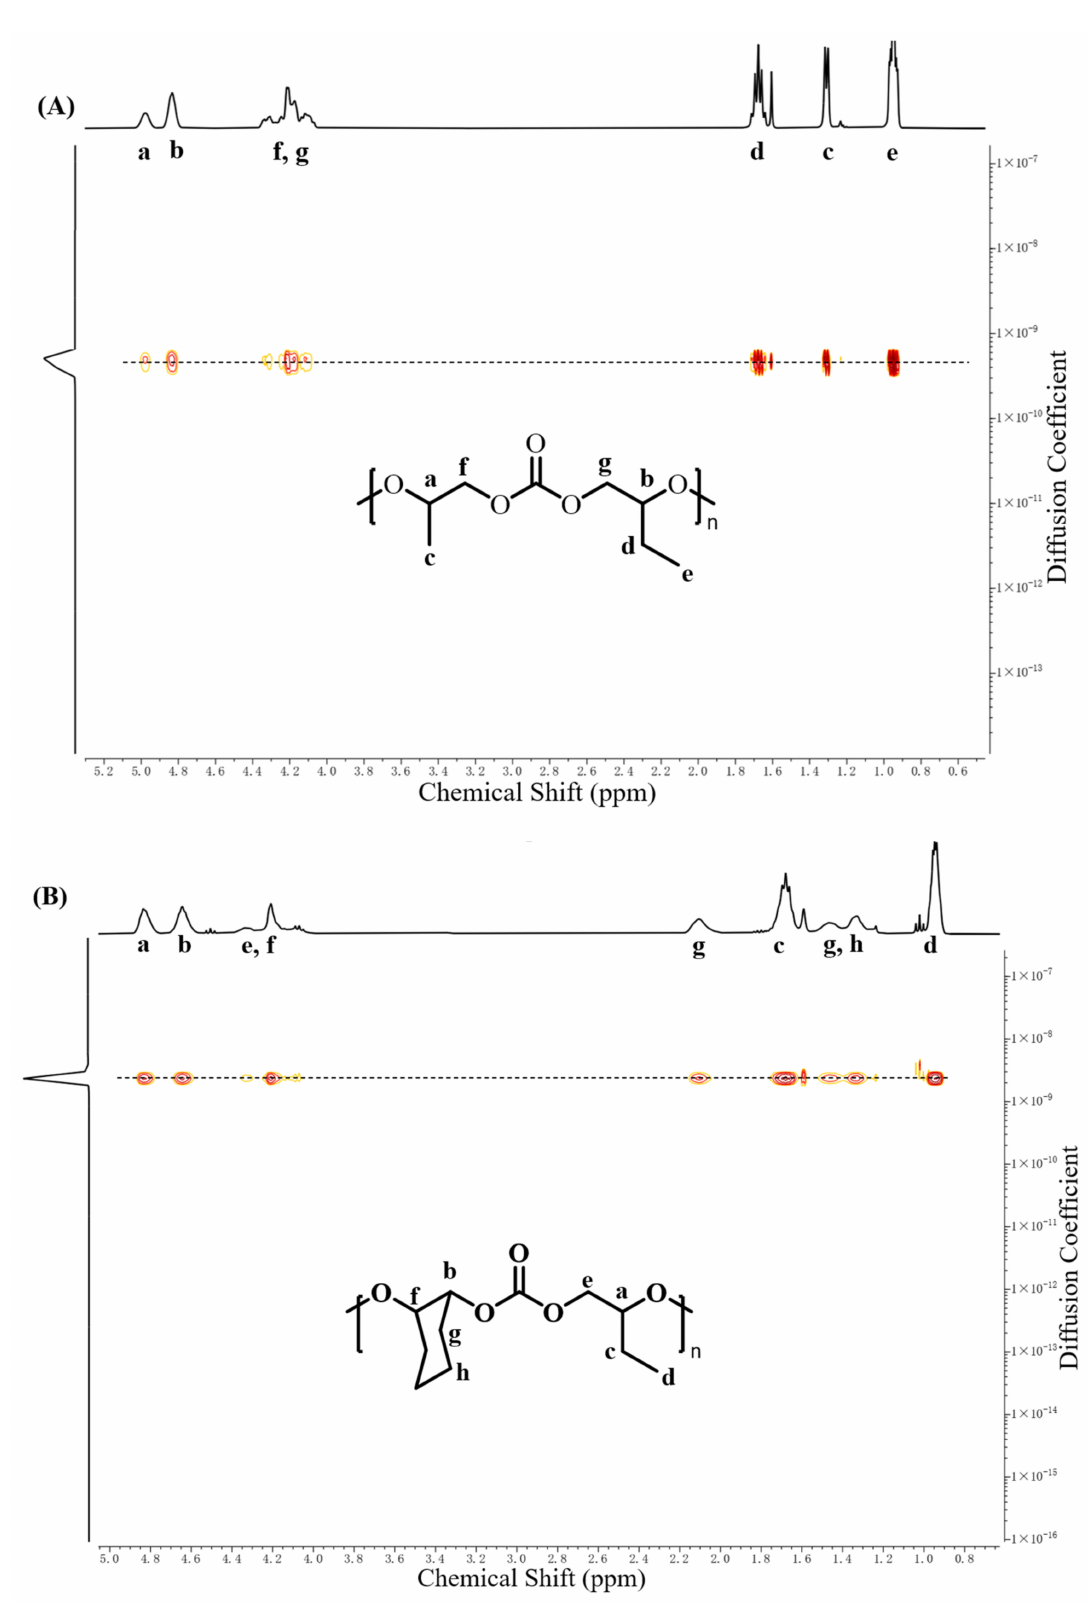
Figure 2. DOSY spectra of ( A ) PBC-co-PPC and ( B )